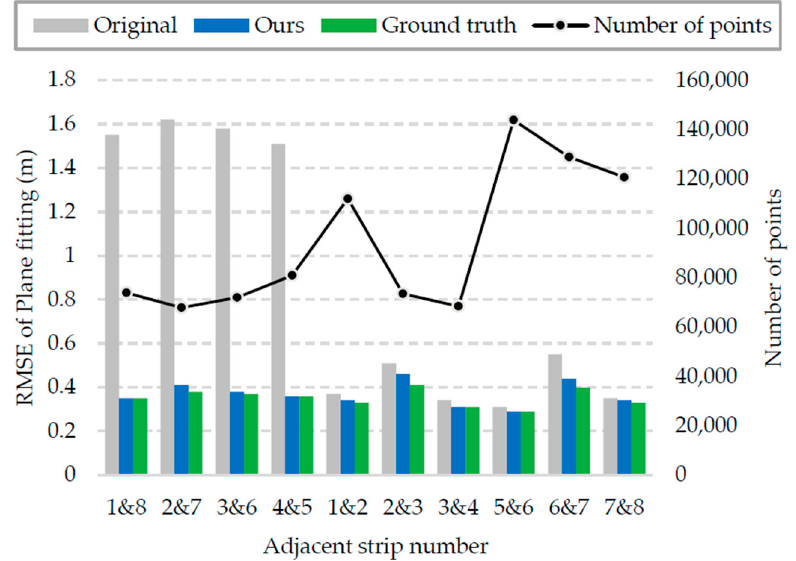
Figure 8. RMSE calculation results, where the grey bar and the blue bar are the RMSE values of each pair of point clouds before and after adjustment, and the green bar is the RMSE value of the ground truth. The black dot is the number of points in the plane where each RMSE value is calculated.